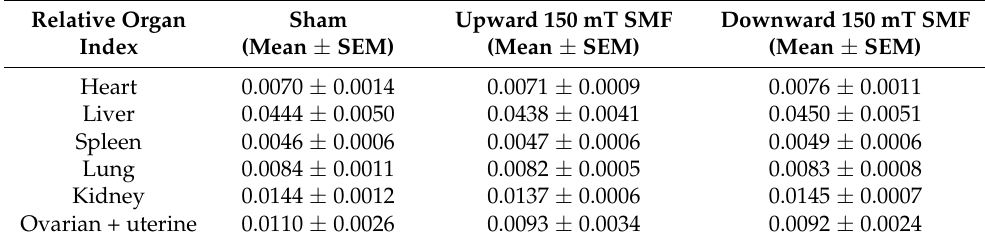
Table 3. Relative organ index of mice exposed long-term to sham, upward and downward 150 mT SMFs. We conducted statistical analysis for all data; comparisons were made between each sham and 150 mT SMF group. All groups contained six mice, and values show mean ± SEM. In consideration of the readability of the paper, no statistical significance ( p > 0.05) was not labeled